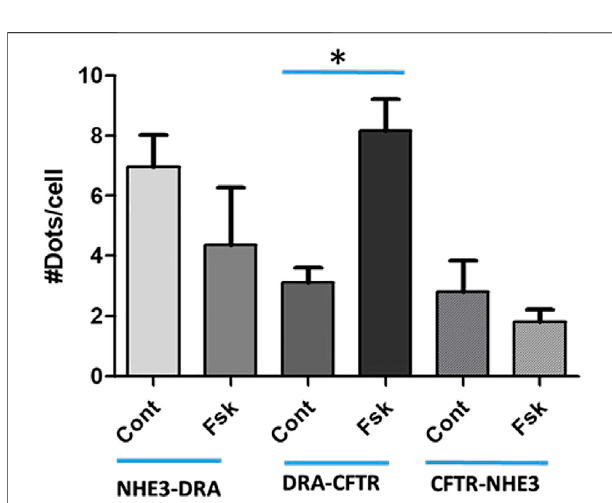
FIGURE 6 | Proximity Ligation Assay (PLA) in Caco-2BBe cells shows direct binding under baseline conditions of NHE3-DRA, DRA-CFTR, and CFTR-NHE3. This binding was dynamic. Ten minutes after forskolin (10 µM) exposure, DRA-CFTR physical association was increased, while the physical association of NHE3-DRA and CFTR-NHE3 decreased. The results are expressed as means ± SEM of fi ve experiments. *, p < 0.05.